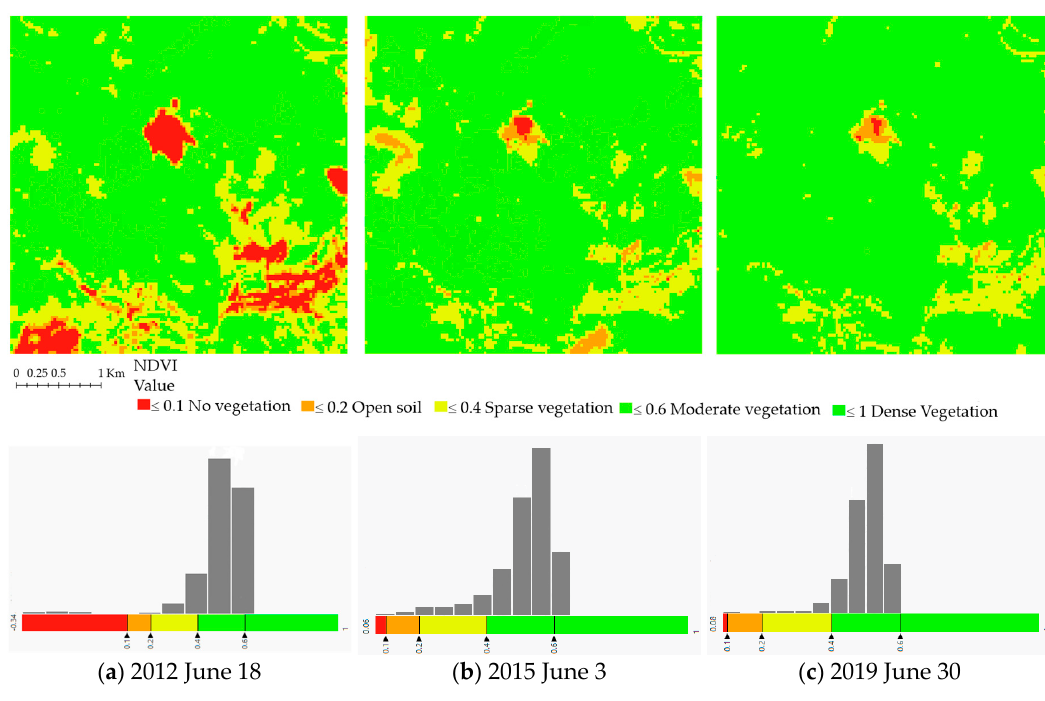
Figure 16. NDVI of open-pit mine for years 2012 ( a ), 2015 ( b ), 2019 ( c ). Table 4. Representation of CLC classes for the reference